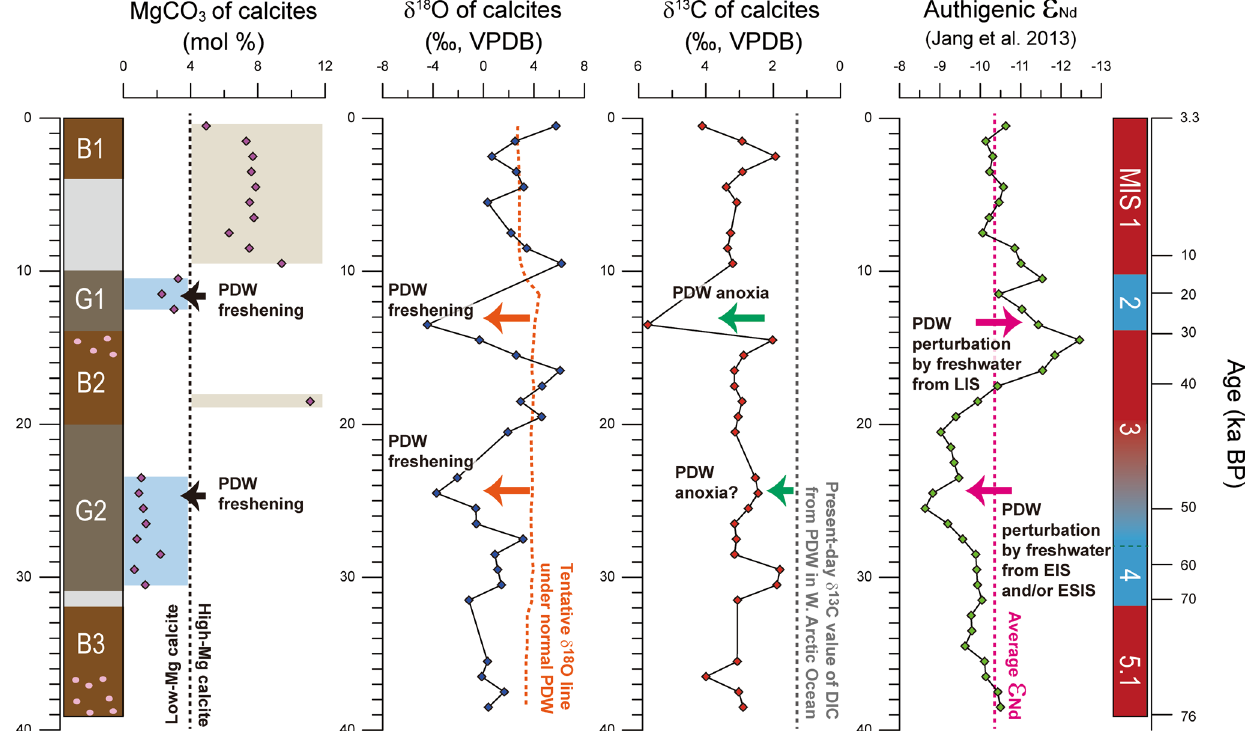
Fig. 4 Downcore variability in MgCO 3 concentrations and stable isotope values ( δ 18 O and δ 13 C) of authigenic calcites as well as authigenic ε Nd at site PS72/410-1. Geochemical records indicate brackish and anoxic environments of the deep Arctic Ocean during stadial periods, resulting from oxygen- depleted freshwater intrusion, as recorded by authigenic ε Nd . Note that data is absent at 13 – 18, 19 – 23 and 31 – 39 cm for Mg contents and 10 – 13, 21 – 23 and 32 – 35 cm for stable